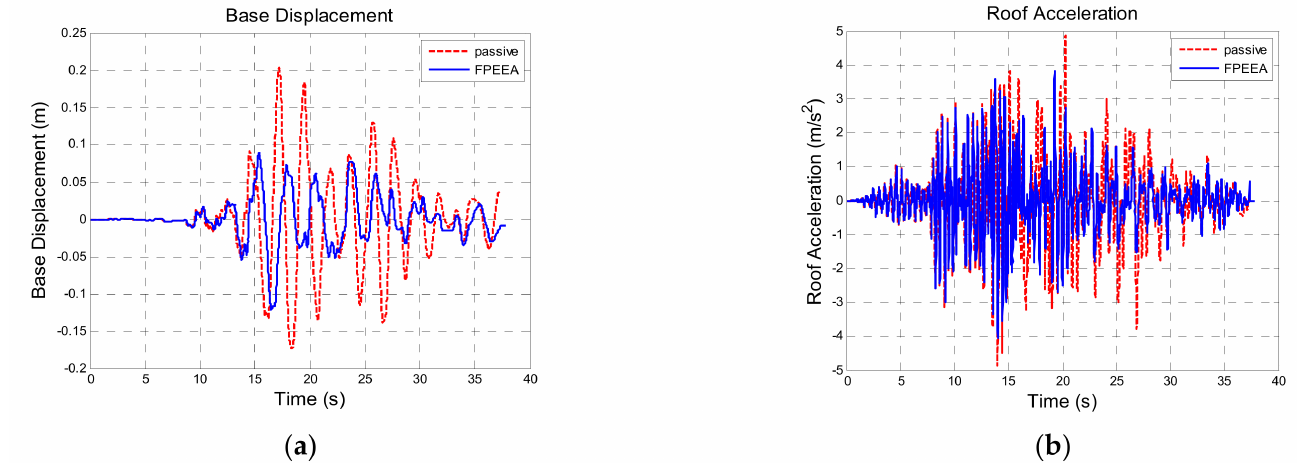
Figure 8. Comparison for the FPEEA and passive controls (Northridge, PGA = 0.3 g). ( a ) Isolation layer displacement. ( b ) Superstructure